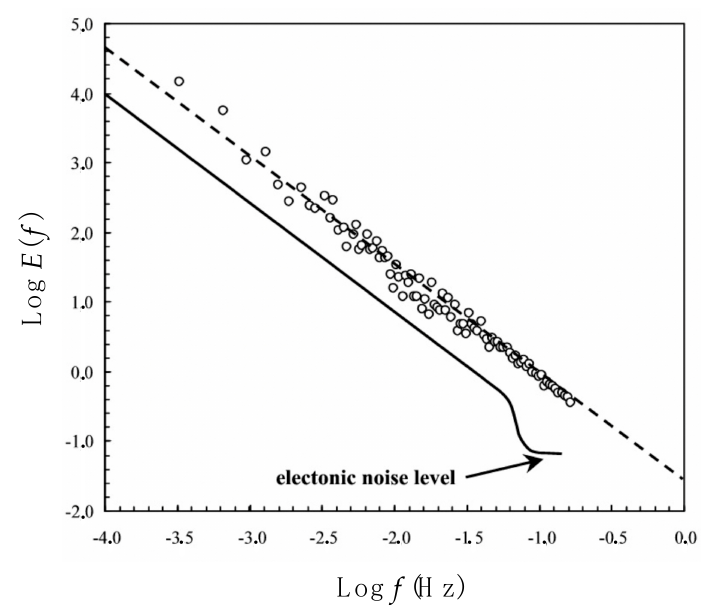
Figure 3. The power spectrum E ( f ), where f is frequency, of an ammonium time series recorded in 1997. The strong linearity of the power spectrum indicates a scaling behavior over the whole range of scales. The spectrum expected in case of noise contamination by the electronics of the processing chain, presenting a high-frequency roll-off towards the electronic noise level, is shown for comparison.